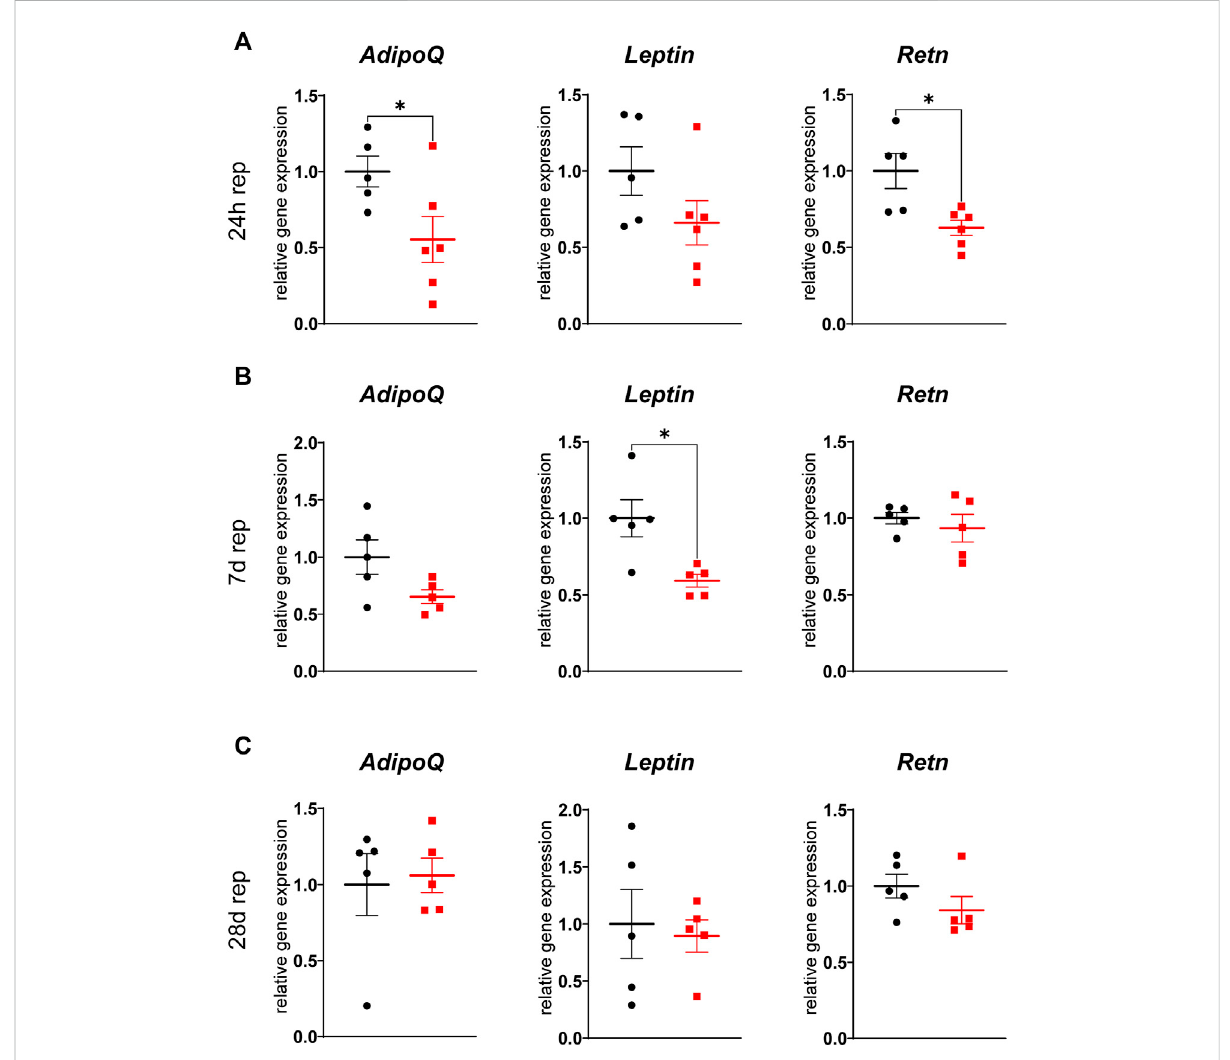
FIGURE 6 ReducedadipokinegeneexpressioniniWATaftercardiacI/RRelativegeneexpressionofadiponectin (AdipoQ) ,leptin( Leptin )andresistin( Retn ) iniWATafter24 h (A) ,7 days (B) ,and28 days (C) ofreperfusion.n=5-6,dataaremean±SEM,Mann-Whitneytestorunpaired,two-tailed t -testwere used, * p <